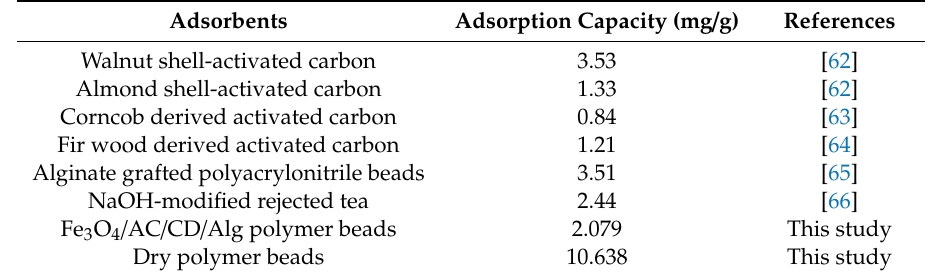
Table 6. Comparison of Fe 3 O 4 / AC / CD / Alg polymer gel beads with previously reported adsorbents.